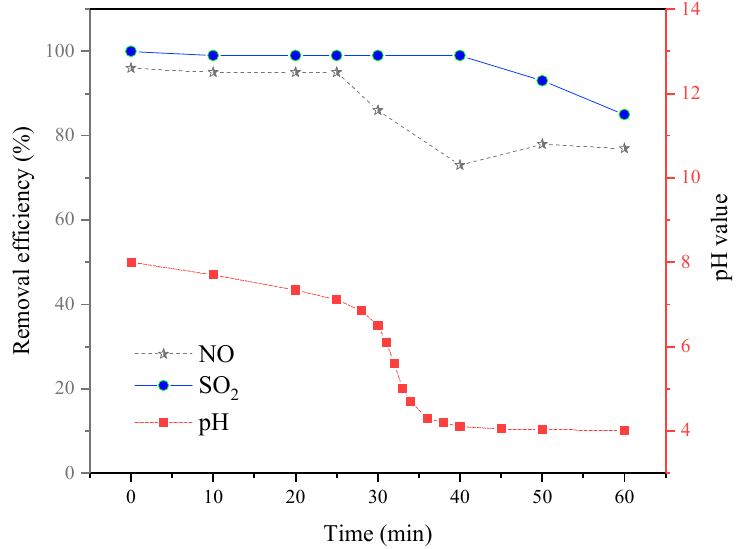
Figure 6. Simultaneous removal of NO x and SO 2 after absorption by seawater and pH with time extension. ([NO], 300 ppm; [SO 2 ], 1000 ppm; n O 3 / n , 1.2; inlet gas temperatures 200 °C; artificial seawater, 30 L.)